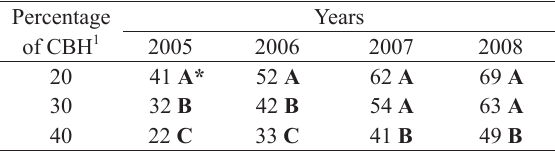
Percentage of bark recovery in Drimys brasiliensis under different percentages of harvesting, in the years 2005, 2006, 2007 and 2008, for experiment